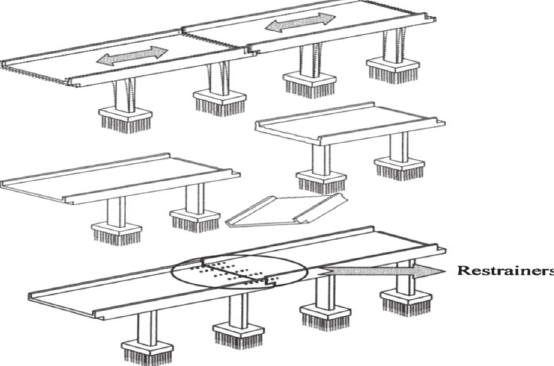
Figure 1: Unseating problems and joint-restrainers placing